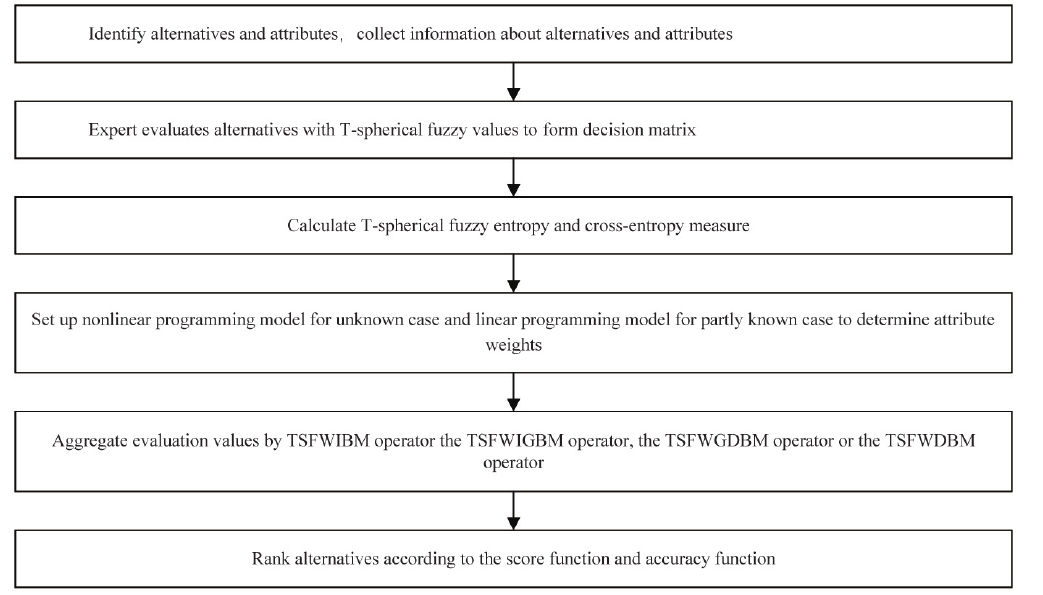
Figure 1. Flowchart of decision making method based on Bonferroni mean